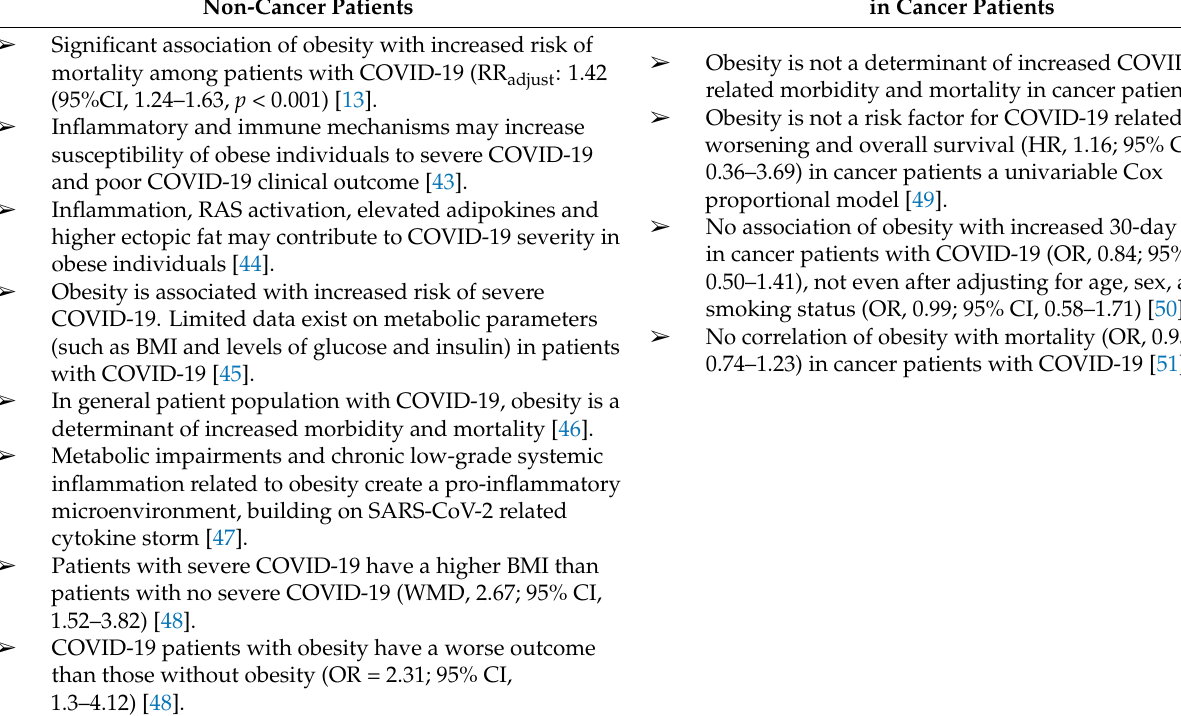
Table 2. Discord in the contribution of obesity to COVID-19 outcome in non-cancer and cancer patients. Discordance about the Contribution of Obesity to Unfavorable COVID-19 Outcome in Non-Cancer and Cancer Patients Obesity is Related to Unfavorable COVID-19 Outcome in Obesity is Not Related to Unfavorable COVID-19 Outcome Non-Cancer Patients in Cancer